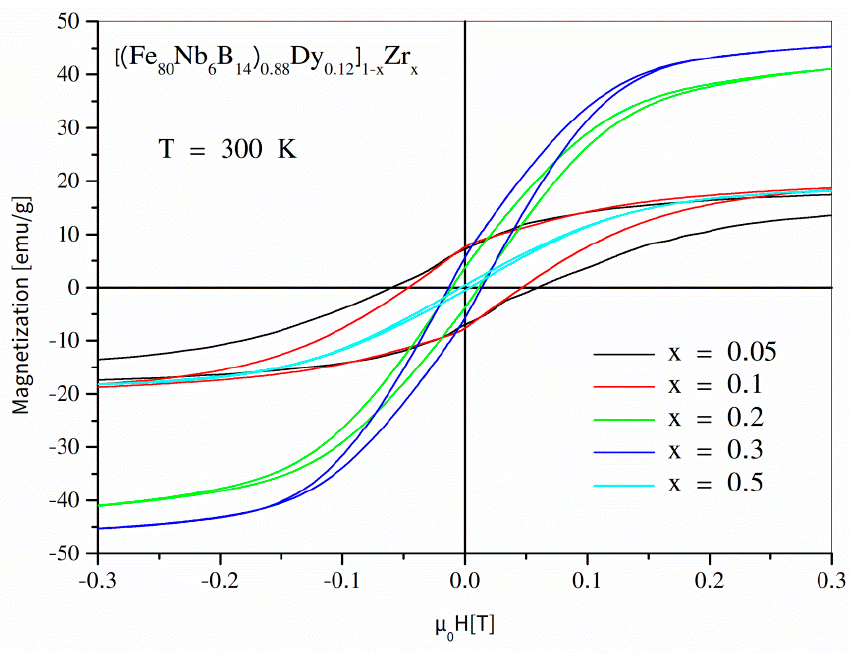
Figure 5. Hysteresis loops for the [(Fe 80 Nb 6 B 14 ) 0.88 Dy 0.12 ] 1 − x Zr x (0.05 ≤ x ≤ 0.5) alloys measured at room temperature.